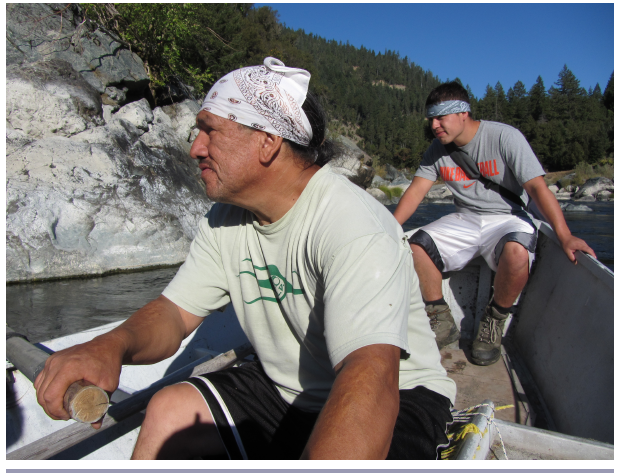
Fig. 3. Ron Reed rowing with his son Jason Jackson-Reed across the Klamath River to dip-net for salmon. Photo by Sibyl